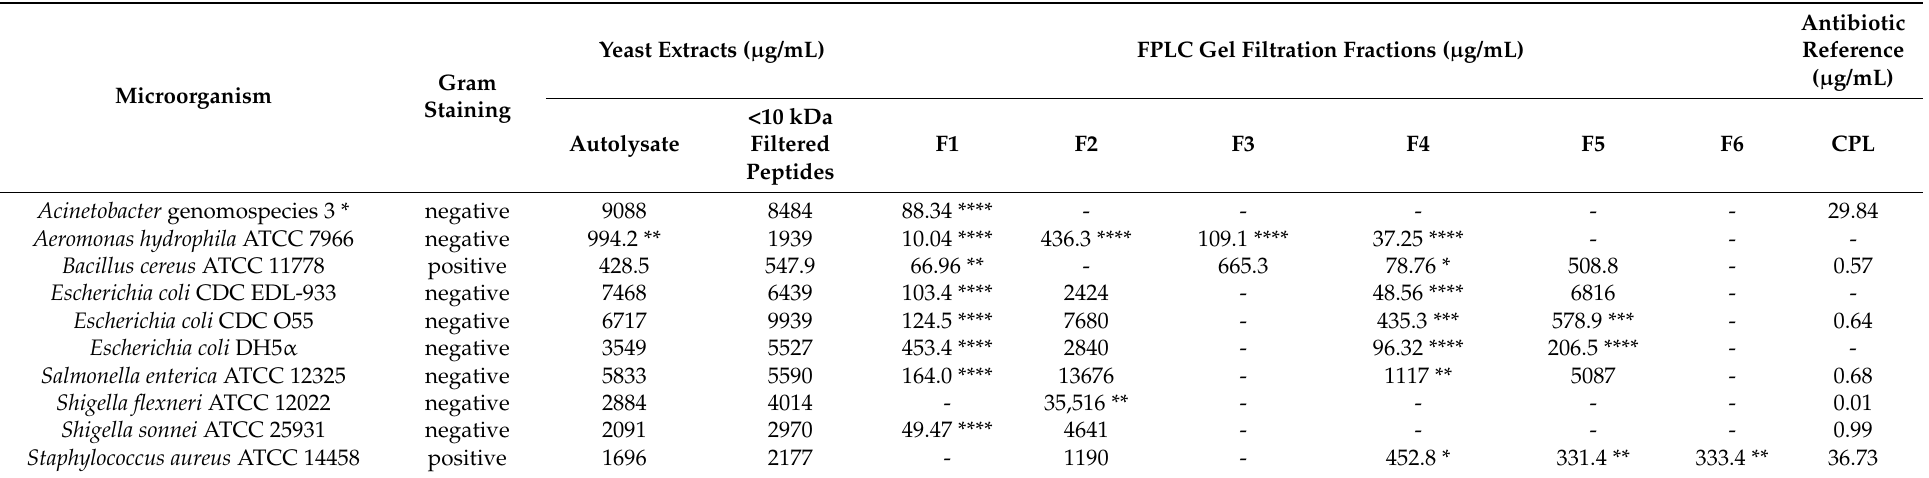
Table 1. Estimated inhibitory potential (IC 50 ) of the autolysate, filtered <10 kDa peptide extract, FPLC gel filtration fractions, and